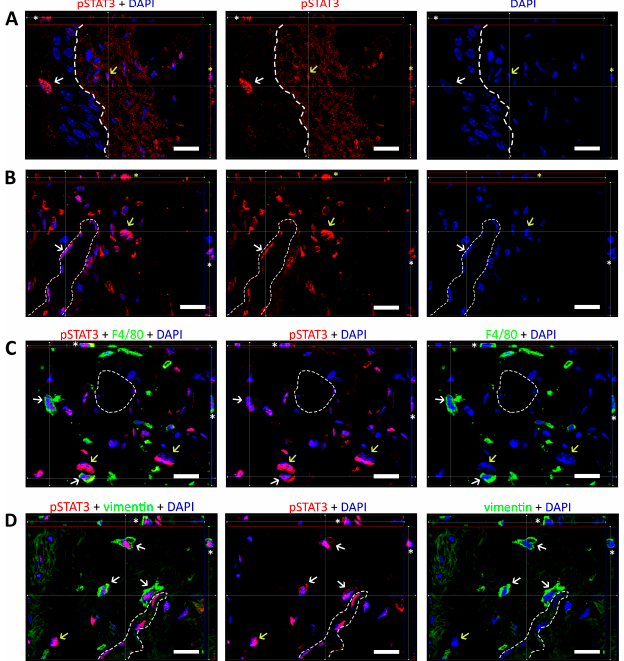
Figure 5. Representative confocal microscopy images of pSTAT3 nuclear translocation in the bladders of CYP-treated mice, selected from a series of images assembling a Z-stack. ( A ) Nuclear expression of pSTAT3 in superficial urothelial cells (white arrows) and interstitial cells of ULP (yellow arrows). A cut-view of the Z-stack shows pSTAT3 immunoreactions in the nucleus of a superficial urothelial cell (white asterisk) and an interstitial cell of the ULP (yellow asterisk). The dotted line indicates the urothelial basal lamina. ( B ) Nuclear expression of pSTAT3 in endothelial cells (white arrows) and the interstitial cells of DLP (yellow arrows). The Z-stack cut-view shows pSTAT3 immunoreactions in the nucleus of the endothelial cell (white asterisk) and interstitial cell of DLP (yellow asterisk). The dotted line indicates the endothelial basal lamina. ( C ) Colocalization of pSTAT3 and F4/80 immunoreactions in some of the interstitial cells of DLP (white arrows). A cut-view of the Z-stack shows pSTAT3 immunoreaction in the nuclei of macrophages (white asterisk). Yellow arrows point to interstitial cells that were not identified as macrophages. The dotted line indicates the endothelial basal lamina. ( D ) Colocalization of pSTAT3 and vimentin immunoreactions in some of the interstitial cells of DLP (white arrows). A cut-view of the Z-stack shows pSTAT3 immunoreactions in vimentin-positive mesenchymal cells (white asterisks). The yellow arrow shows an interstitial cell of non-mesenchymal origin. The dotted line indicates the endothelial basal lamina. Scale bars: 20 µ